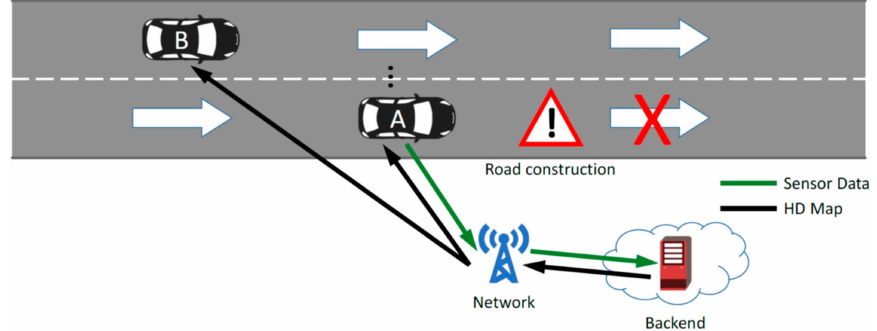
Figure 2. Schematic overview of the high-definition map use